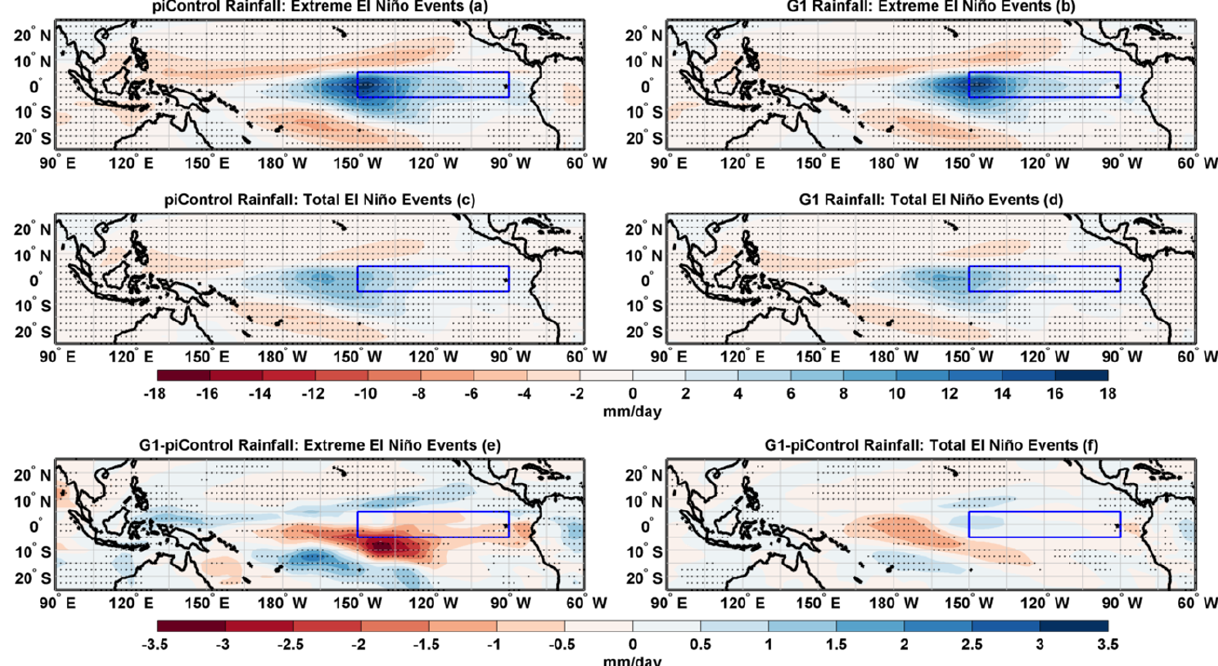
Figure 10. Composites of rainfall anomalies for extreme El Niño events in (a) piControl and (b) G1. Composites of rainfall anomalies for the total number of El Niño events in (c) piControl and (d) G1. Composite differences (G1 − piControl) of rainfall anomalies for (e) extreme El Niño events and (f) total number of El Niño events. Stipples in (a) – (d) and (f) indicate grid points with statistical significance at 99%cl whereas in (e) at 95%cl using a non-parametric Wilcoxon rank-sum test. The blue box in the eastern Pacific identifies the Niño3